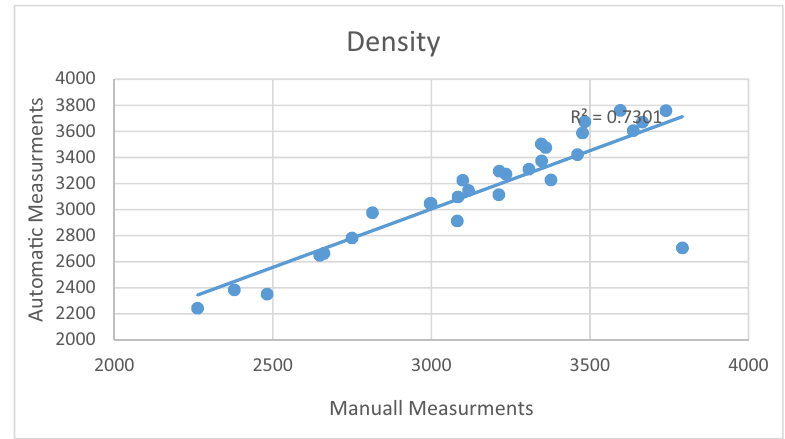
Figure 16: Correlation for the density feature for the images segmented using Watershed Transform - based model.